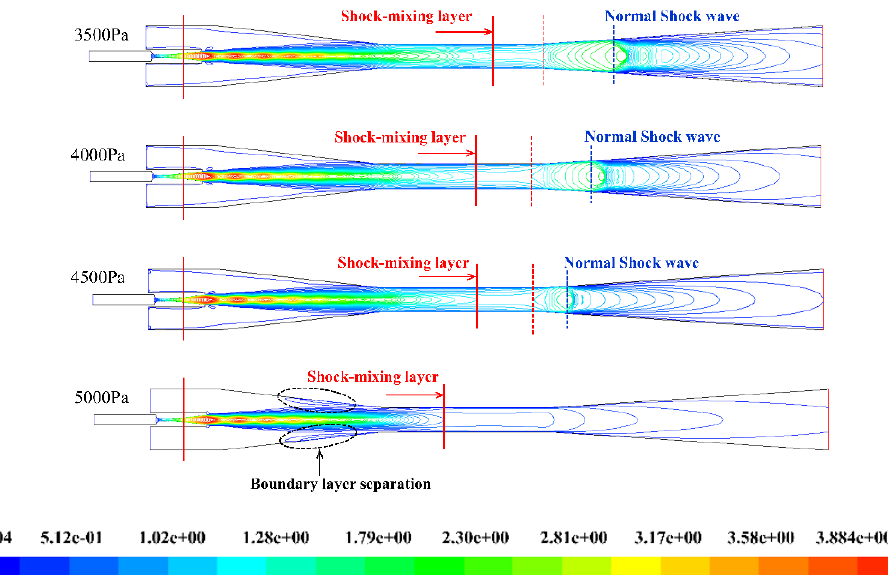
Figure 14. Contours of Mach number for various back pressure.